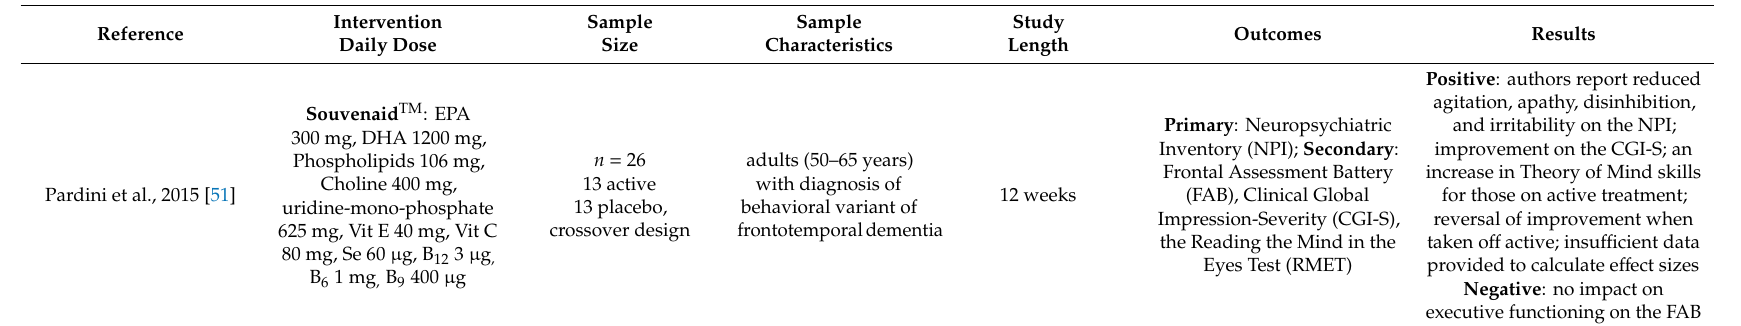
Table 5. Behavioral issues in dementia study ( n =